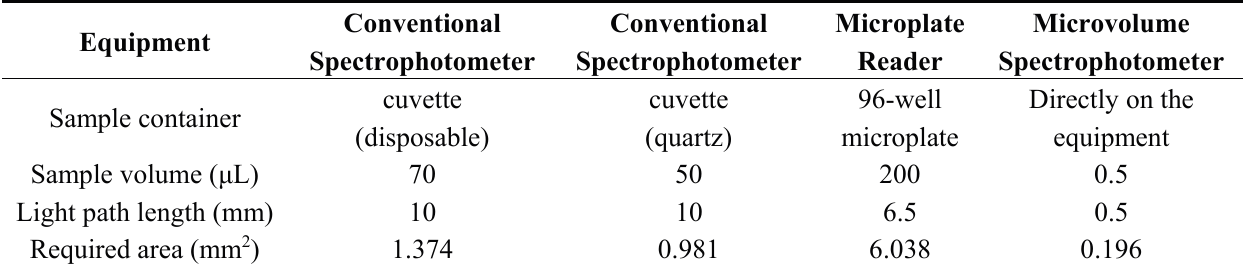
Table 2. The cell immobilization area required to detect 5 μ M of paraoxon in 5 min using typical spectrophotometric sensing